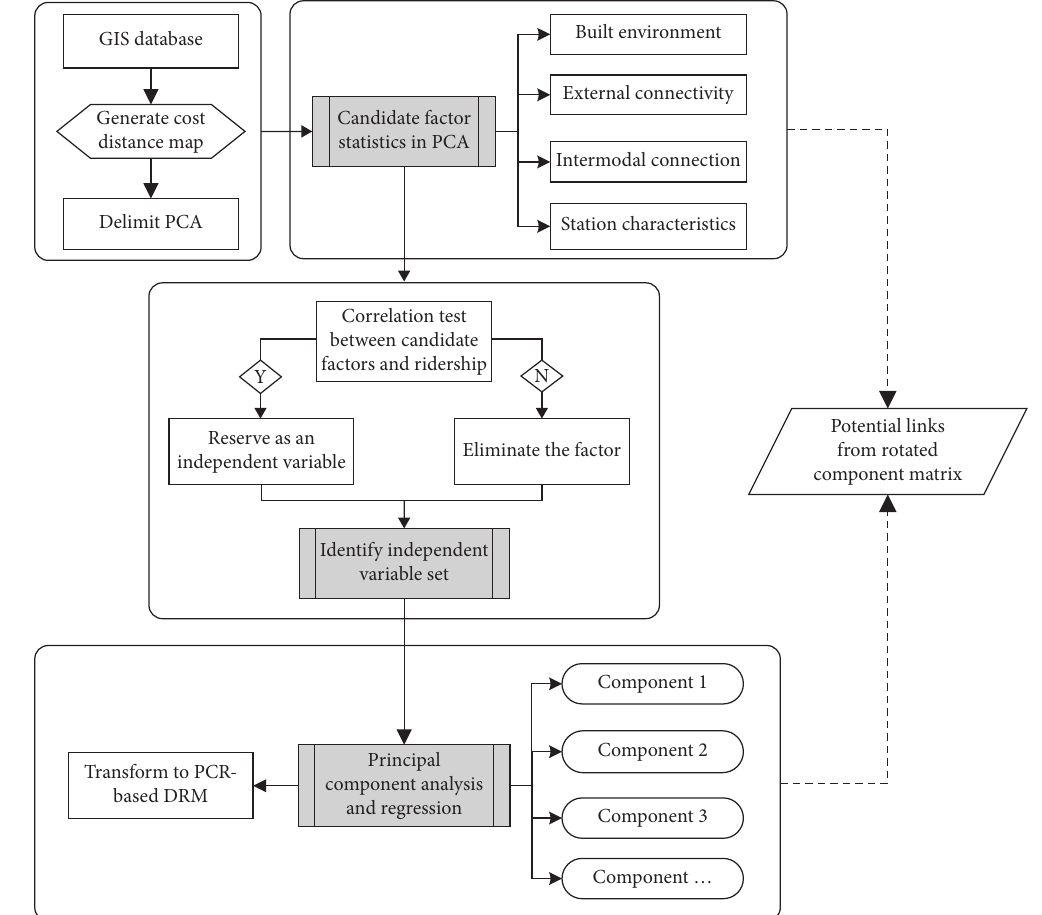
Figure 2: Framework of the PCR-based DRM